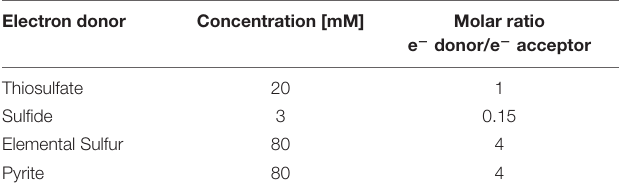
TABLE 1 | Concentration of electron donors in each batch bottle and molar ratio of e − donor/e −